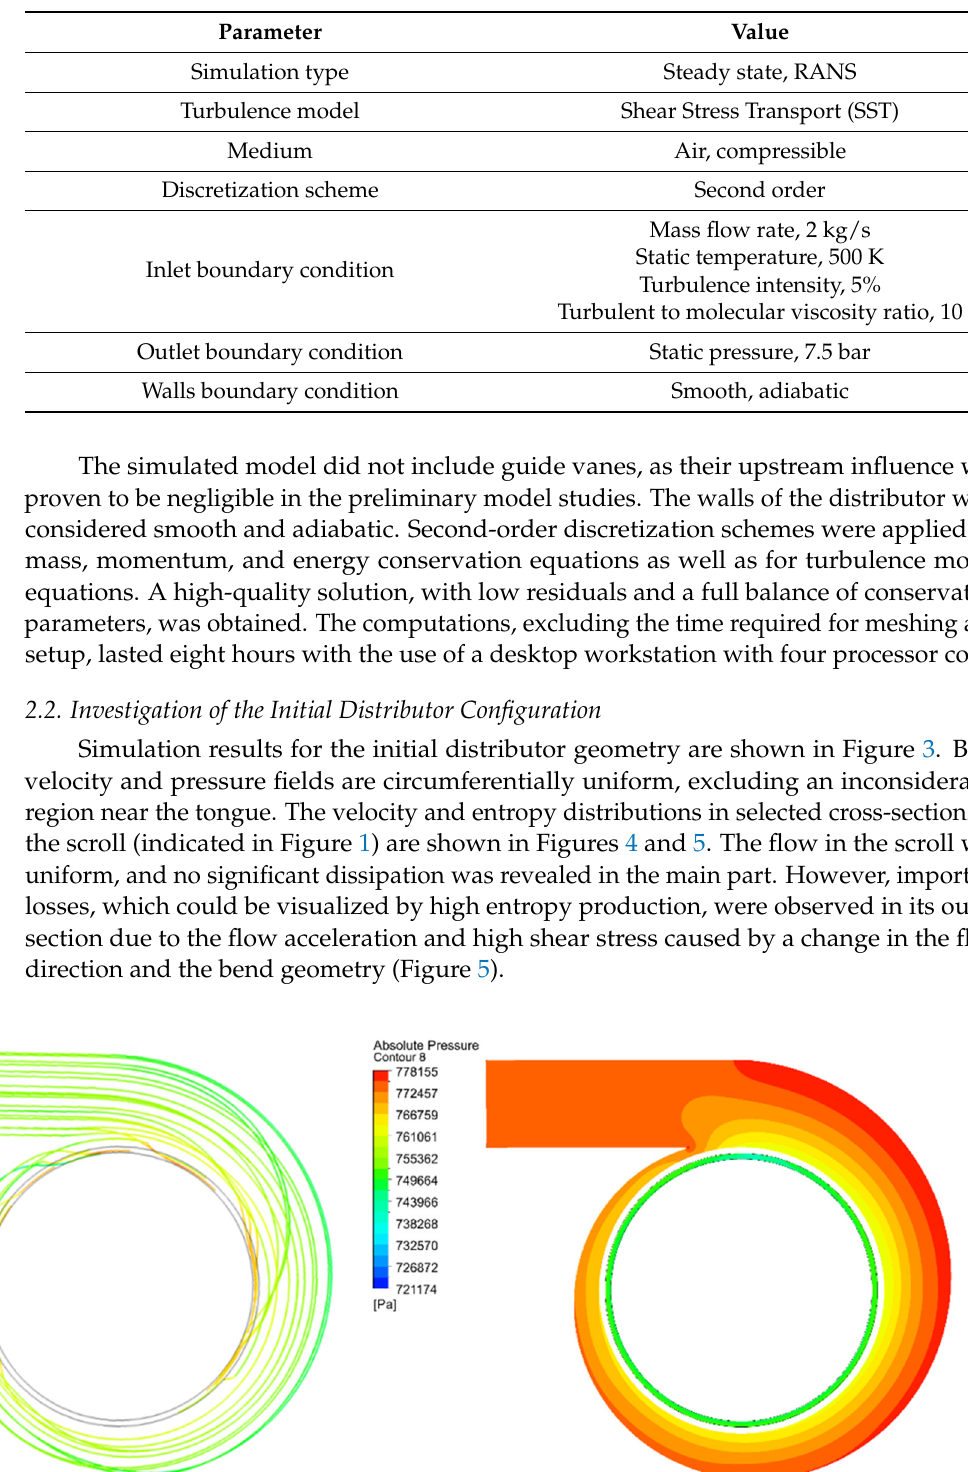
Table 1. Numerical model settings for the 3D simulation.